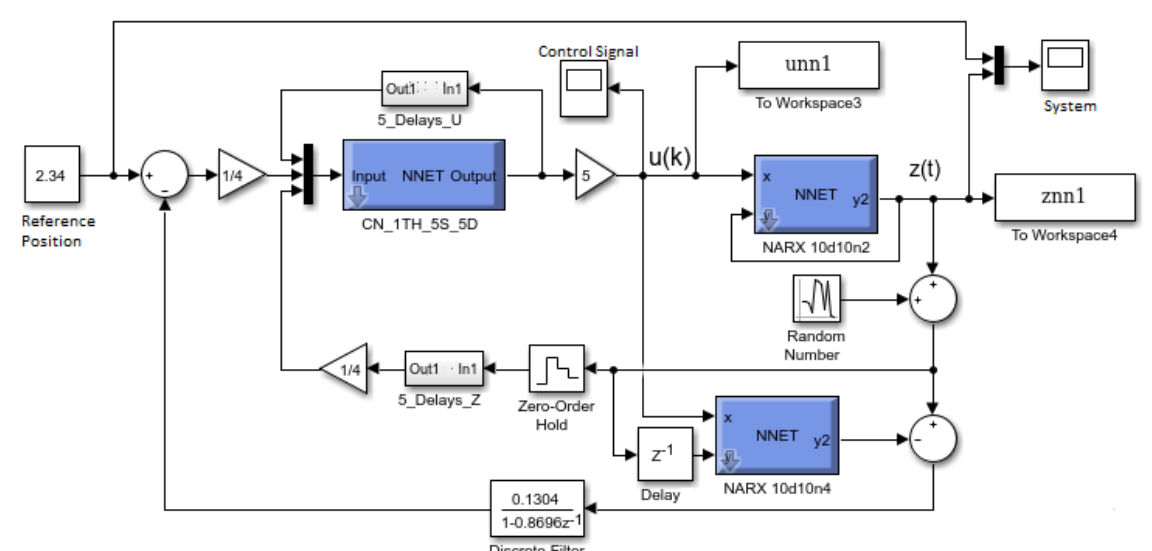
Figure 21. Simulink diagram of the internal model controller.